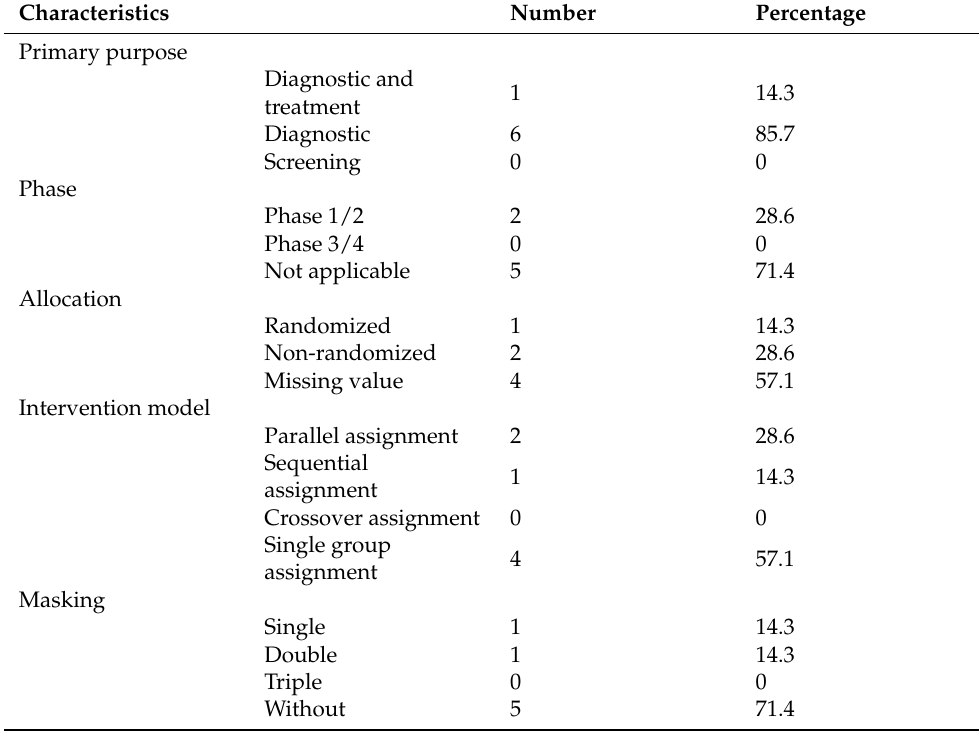
Table 2. The characteristics of the interventional trials.